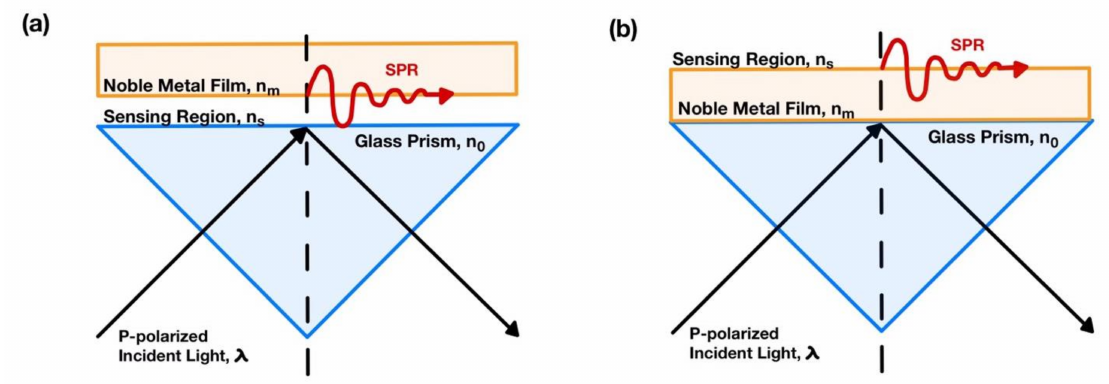
Figure 1. ( a ) The Otto configuration; and ( b ) the Kretschmann configuration.